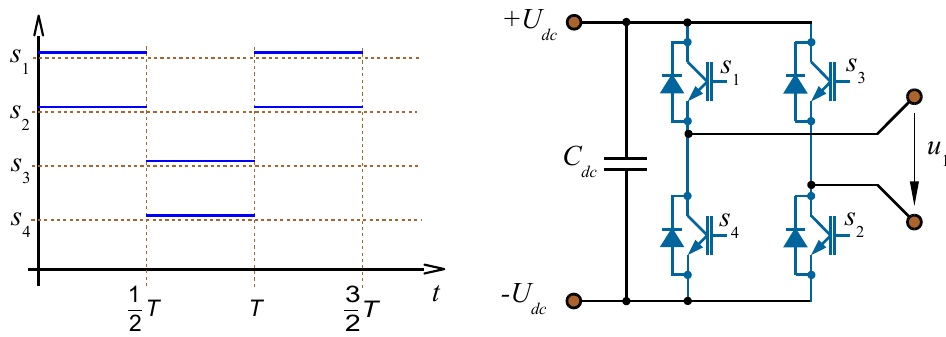
Figure 6. Switching diagram ( left ) and primary voltage-source inverter configuration ( right ).